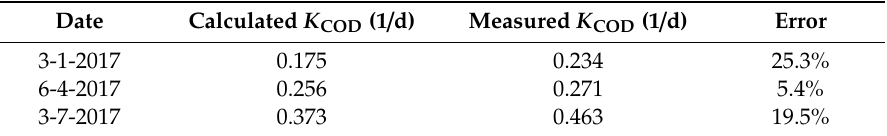
Table 5. Comparison between the calculated and observed